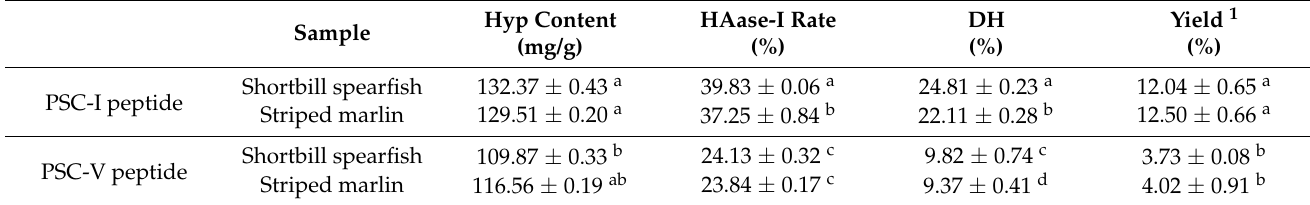
Table 1. Properties of type I and V collagen peptides prepared from fish skin.